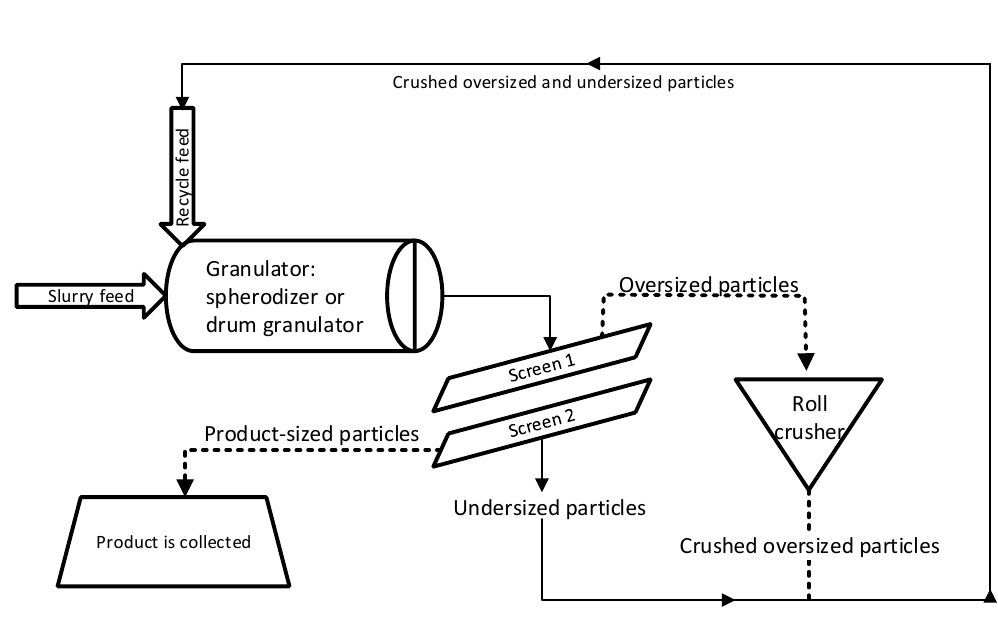
Figure 1: Schematic diagram of granulation